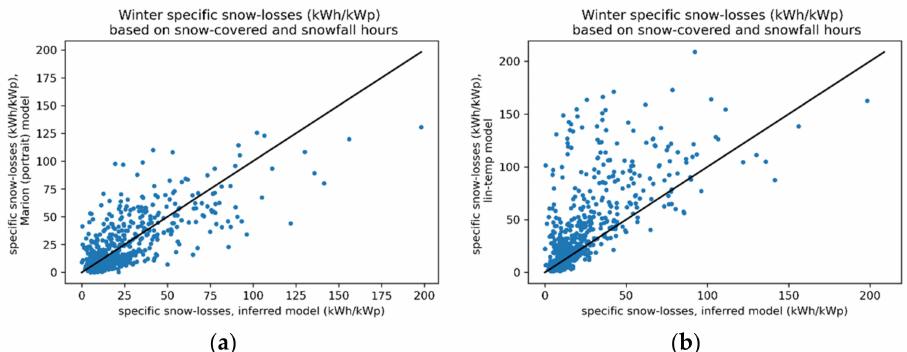
Figure 9. Scatterplots for estimated winter season snow losses (September-May for 2014–2020) from the inference method described in this article and two existing snow loss models (energy losses normalized by installed peak power (DC, STC)): ( a ) Marion model [10], assuming arrays with unknown module mounting to have three rows of portrait-mounted modules. A single outlier point is left out and ( b ) lin–temp model